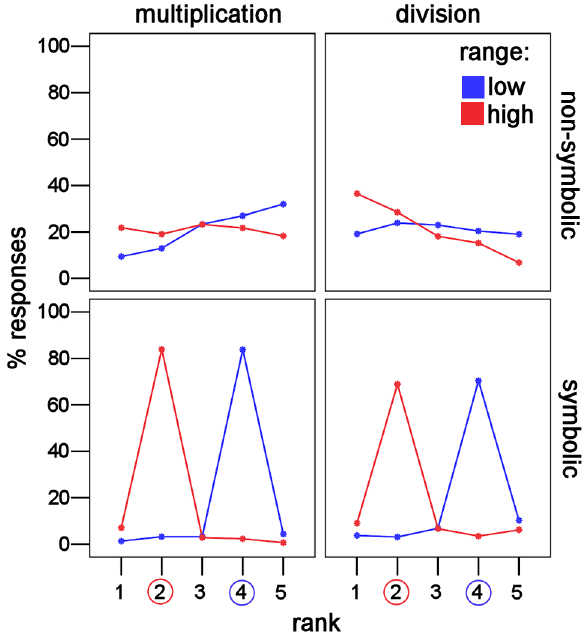
Figure 2. Non-random distribution of responses. Symbolic response percentages were non-random and peaked at the correct result. Rank (1–5) had a significant effect on response percentage for both low (blue, 4 nd correct) and high (red, 2 nd correct) ranges. Non- symbolic responses were non-random, depending on the response range presented. Rank had a significant effect on response percentage for multiplication when the low (blue) range was presented and for division when high (red) range was presented. This indicates that subjects were not guessing, but rather using a calculation based